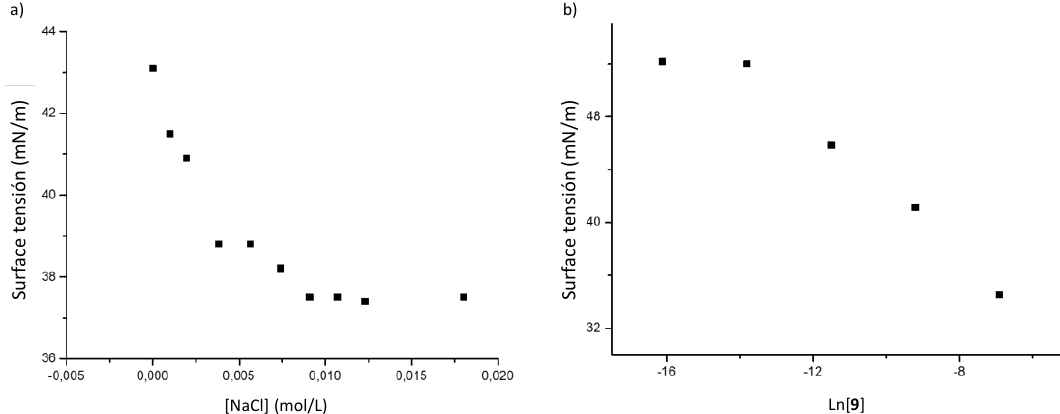
Figure 3. ( a ) Surface tension measurement of a 1 mM solution of dendron C 3 F 7 CONHG 2 (SNMe 3 Cl) 4 ( 9 ) at increasing concentration of NaCl; ( b ) Surface tension measurements of dendritic wedge C 3 F 7 CONHG 2 (SNMe 3 Cl) 4 ( 9 ) at the ionic strength of 12 mM of NaCl. A CMC determination from an aqueous solution of dendritic wedge 9 was studied by increasing the concentration of dendrons from 10 −7 to 10 −3 M (Figure 3b). Regrettably, it was not possible to reach